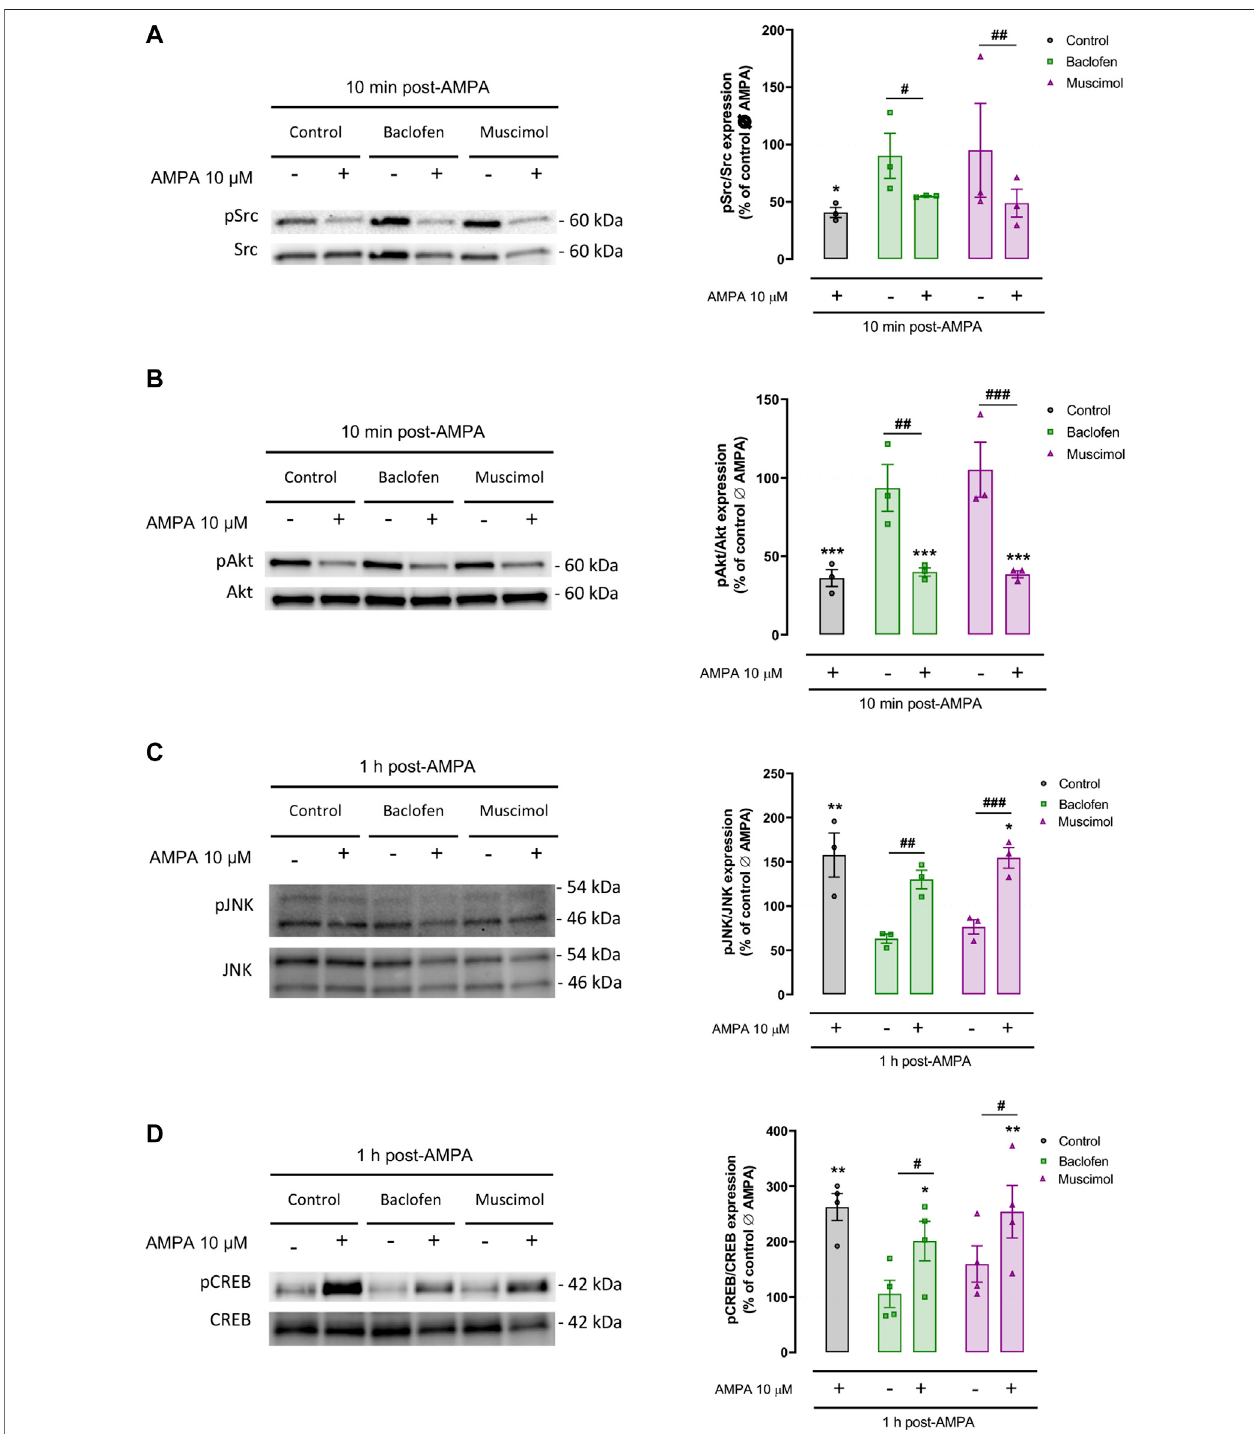
FIGURE4|BaclofenandmuscimoldonotmodulateAMPA-activatedSrc,Akt,JNKandCREBsignalingpathways .WesternblotofphosphorylatedSrc (A) , Akt (B) , JNK (C) and CREB (D) protein levels, normalized to the total protein, in oligodendrocytes treated with baclofen or muscimol before exposure to AMPA, and analyzed 10 min or 1 h after AMPA stimulus. All conditions were normalized to values from untreated cells, which was considered as 100% of phosphorylated protein expression levels. Data are shown as the mean ± SEM of at least 3 independent experiments. *p < 0.05, **p < 0.01, ***p < 0.001 vs. control Ø AMPA; #p < 0.05, ##p < 0.01, ###p < 0.001 vs. ØAMPA one-way ANOVA.